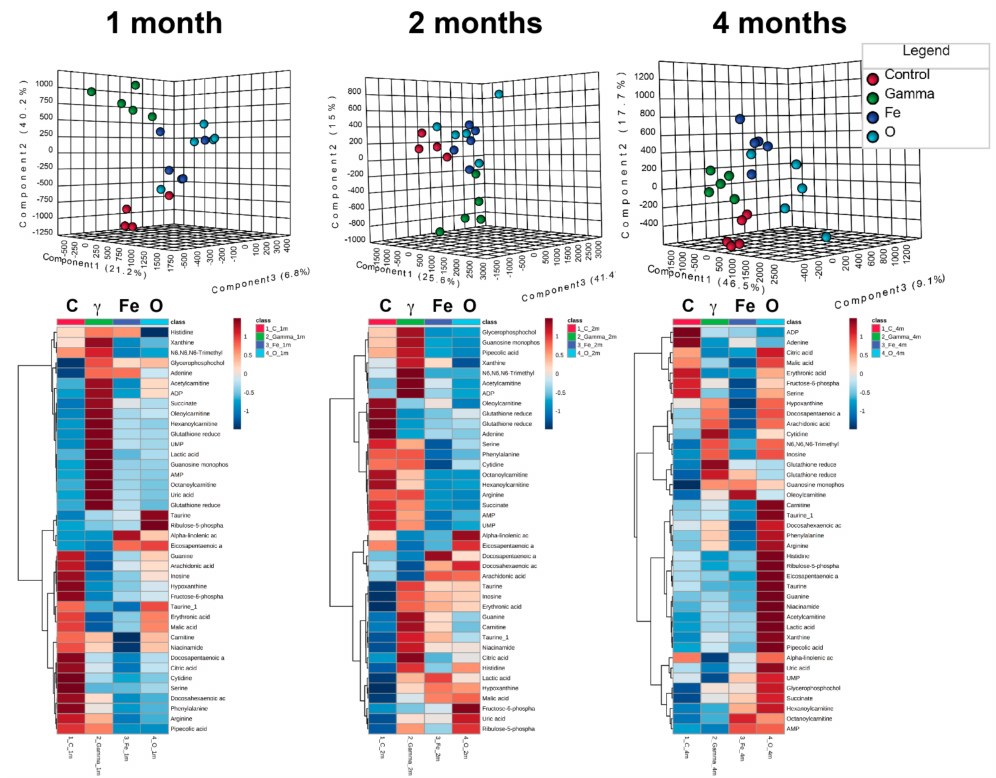
Figure 2. Multivariate data analysis on validated metabolites. Forty metabolites were identified through MS/MS and evaluated at 1, 2, and 4 months after irradiation. Distinct clustering in the partial least squares discriminant analysis (PLS- DA) scores plots is seen in all time points, while differential levels of the individual metabolites highlight the differences between the different exposures over time.